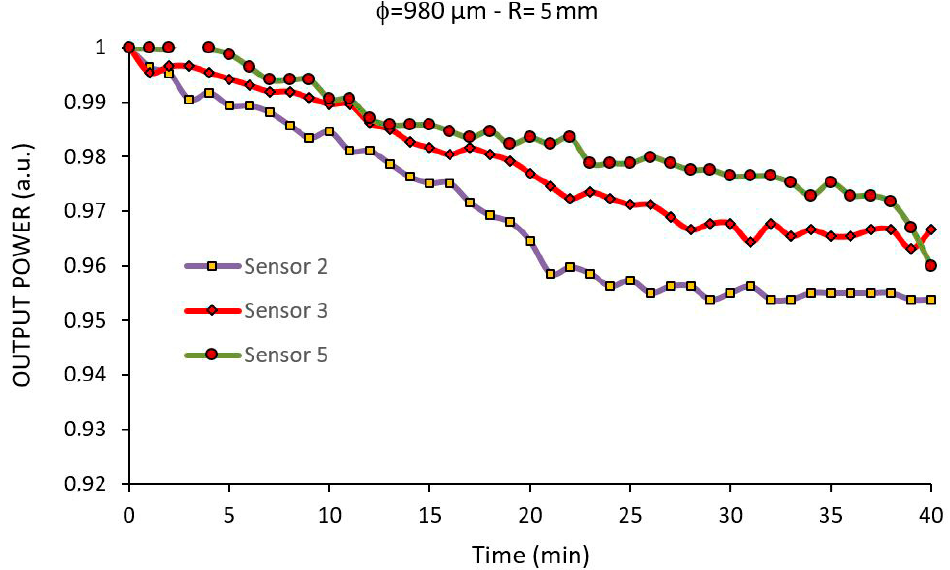
Figure 8. Experimental response of three 980 µ m diameter with 5.0 mm curvature radius of U-Shaped sensors for a 10 8 CFU/mL suspension of E. coli in saline solution.